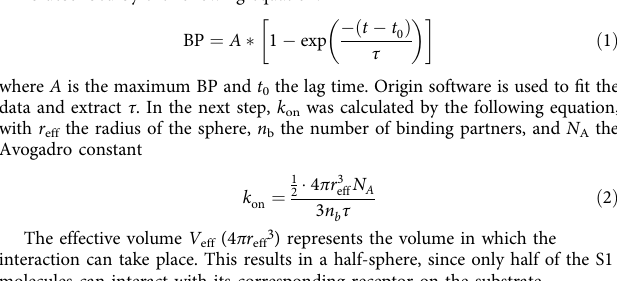
where A is the maximum BP and t 0 the lag time. Origin software is used to fi t the data and extract τ . In the next step, k on was calculated by the following equation,